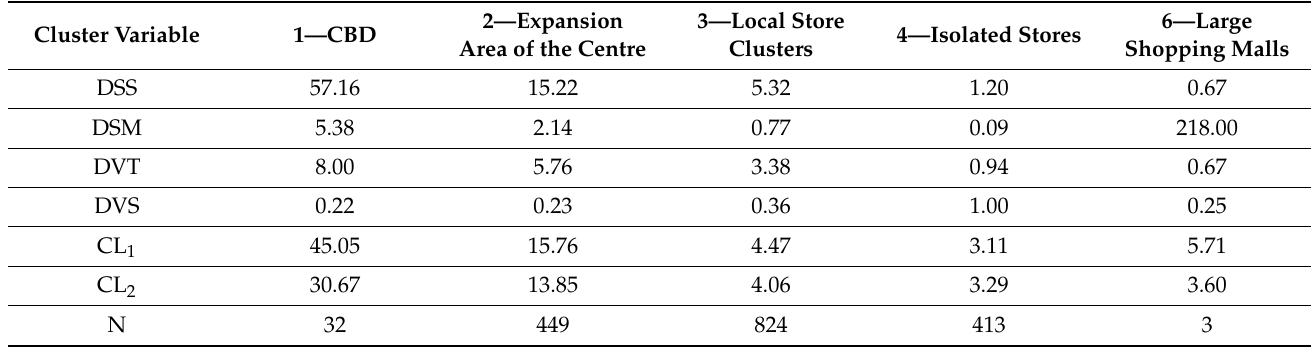
Table 4. Commercial Variables in 2010—Mean Value considering Cluster Membership.